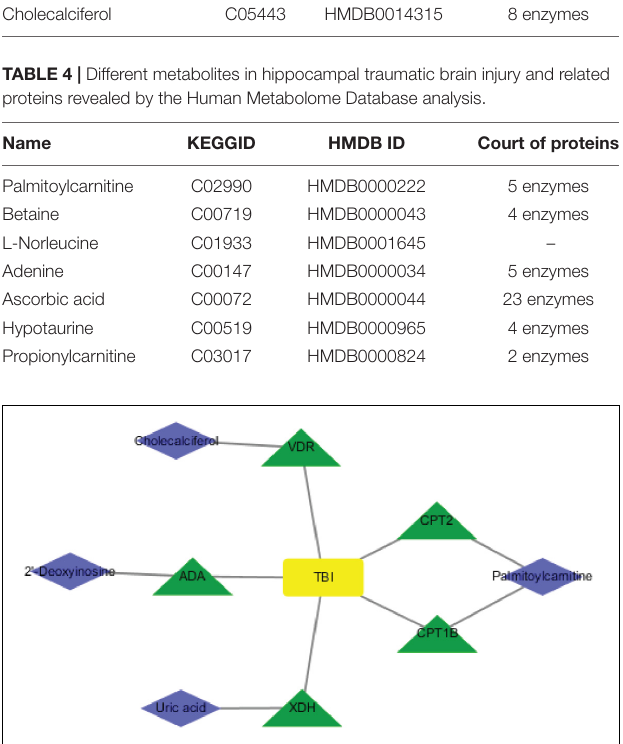
FIGURE 10 | Perspective of traumatic brain injury (TBI) perturbation on integrated proteins, cortical metabolites: a network of TBI-causing candidate proteins (green and triangle) and cortical metabolites (blue and